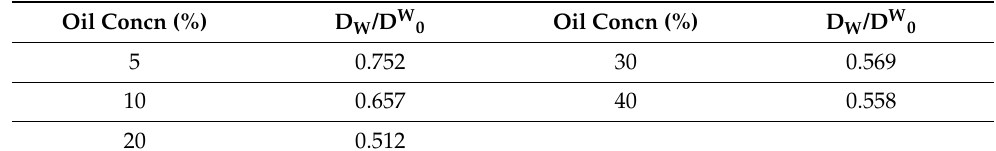
Table 1. Relative Diffusion Coefficient Values of Water in a Nanoemulsion Loaded with Quercetin at 10% Emulsifier Content and Calculated from NMR Results at 25 ◦ C [2]. Oil Concn (%) D W /D W 0 Oil Concn (%) D W /D W 0 5 0.752 30 0.569 0.657 0.558